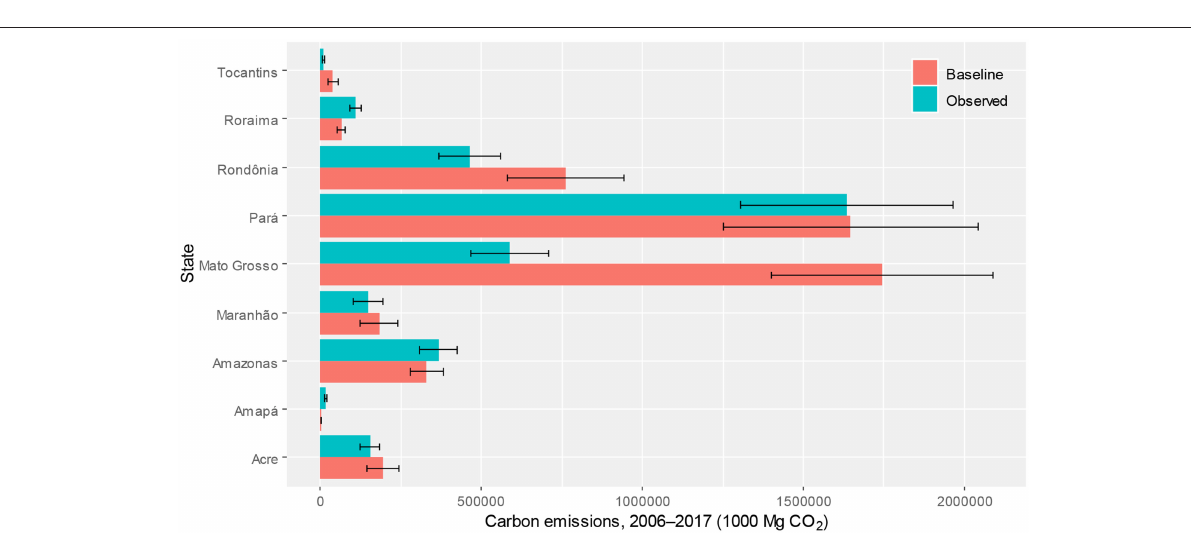
the atmosphere. The state of Mato Grosso alone contributed to 1.2 ± 0.2 Pg CO 2 (74%) of the total emission reductions, followed by Rondônia (0.3 Pg CO 2 ; 19%). At the state level, proportional emission reductions were the highest in Tocantins ( − 75%), followed by Mato Grosso ( − 67%), Rondônia ( − 39%),